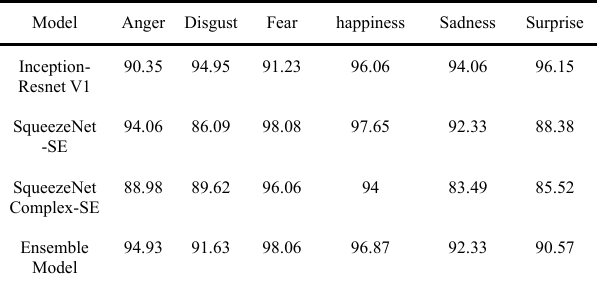
Table 2. Accuracy (%) per expression on dataset Oulu-CASIA.